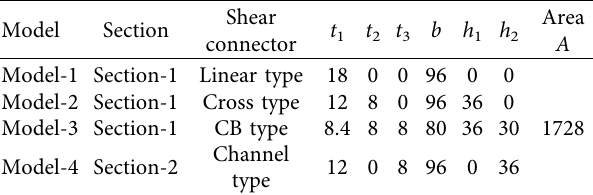
Figure 10: FE model of shear connectors. Table 1: Parameters of shear